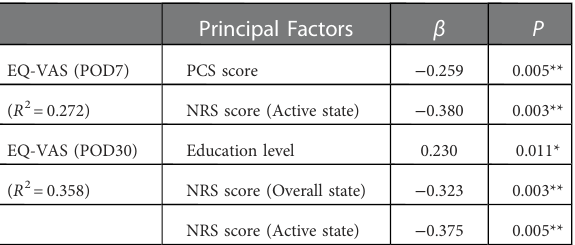
TABLE 6 Analysis of principal factors affecting EQ-VAS score at 7th and 30th days after surgery.